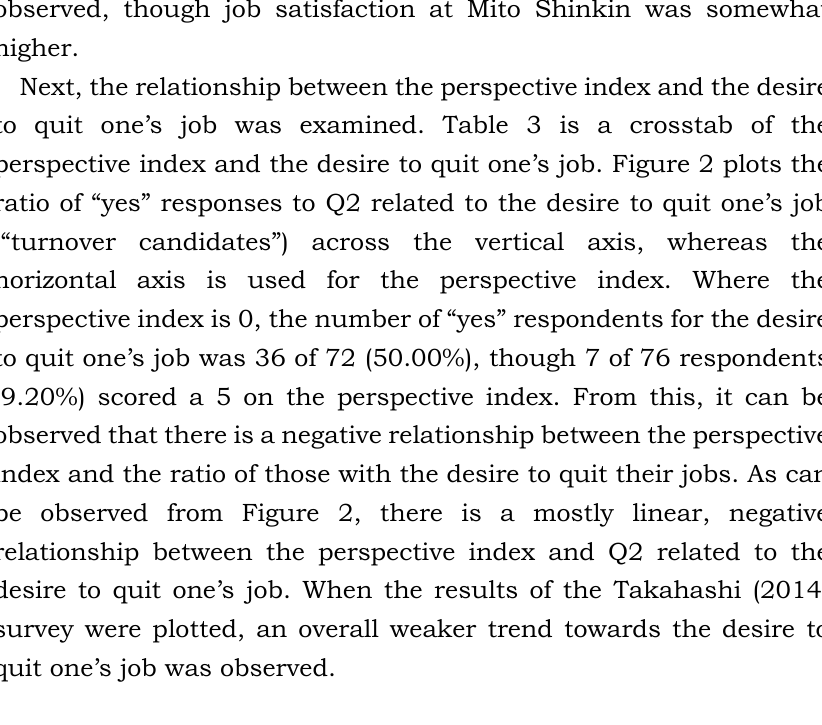
Table 3. Cross table of Perspective index